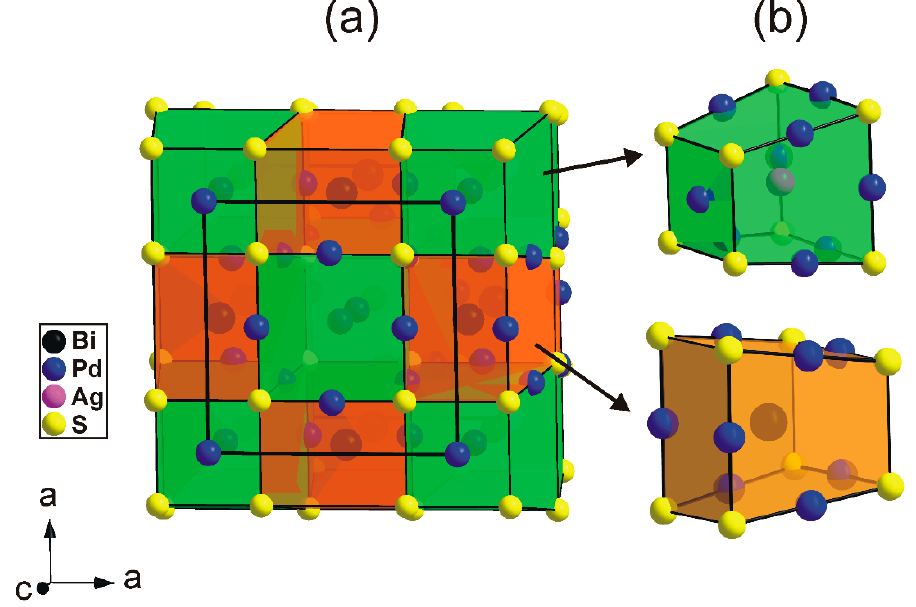
Figure 6. ( a ) Arrangement of two types of building blocks in the thalhammerite structure. ( b ) Detailed view showing the block containing Ag (green) and Bi (orange) atoms.